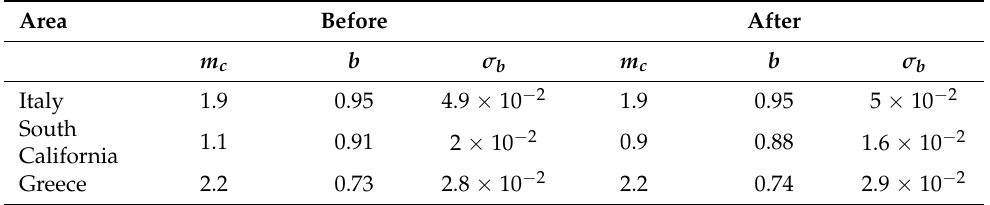
Table 2. The values of m c , b and σ b before and after the lockdown dates for each area here investigated. Area Before After m c b σ b m c b σ b 1.9 0.95 4.9 × 10 − 2 1.9 0.95